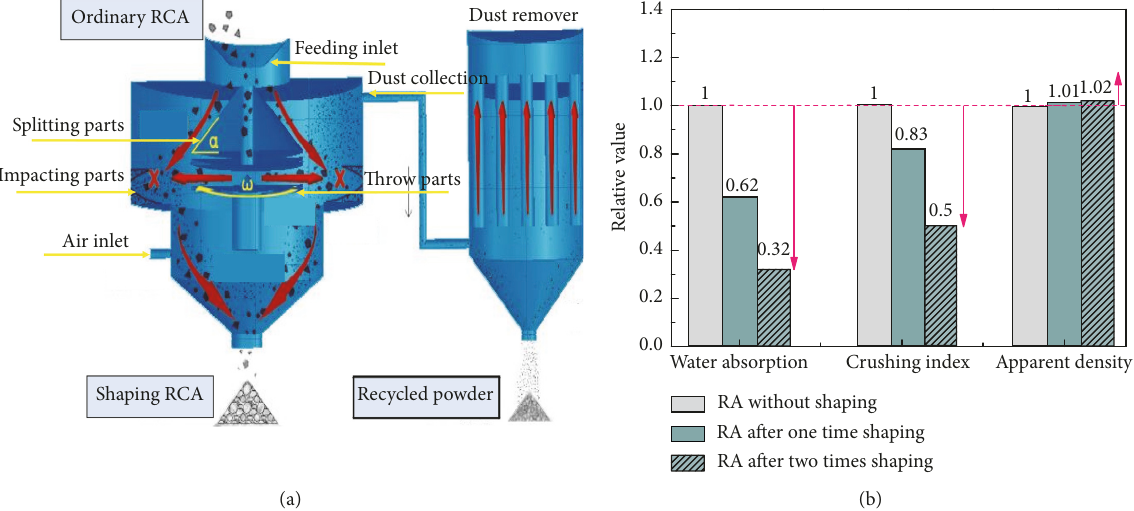
Figure 12: Fundamental characteristics of RCA with and without shaping. (a) Particle shaping equipment [162, 163]. (b) Properties of RA after various shaping cycles [164].